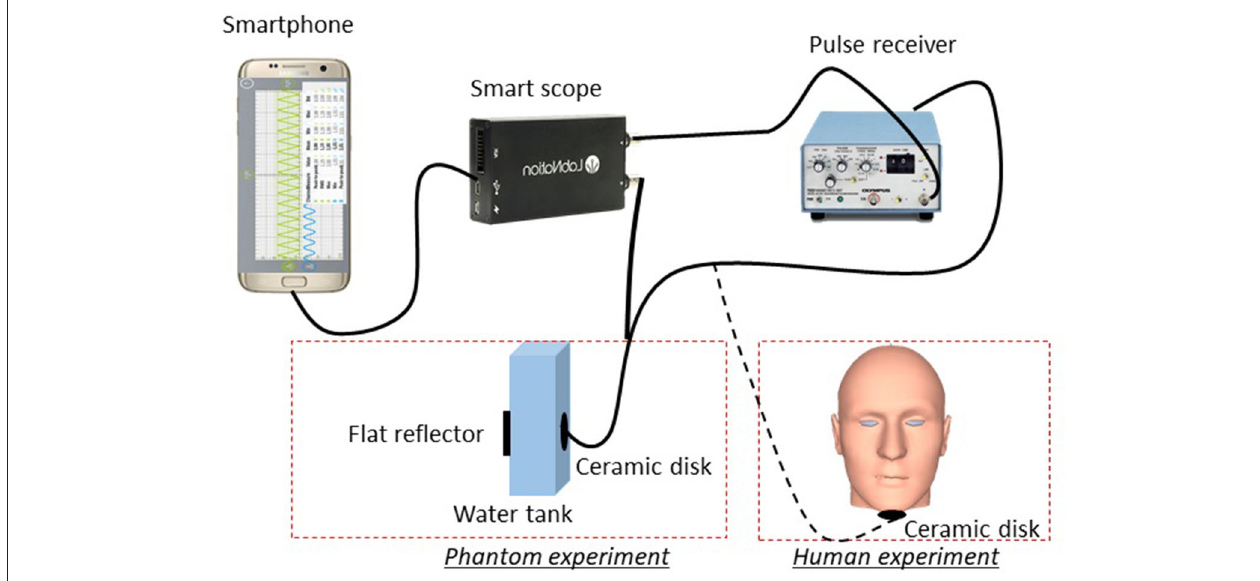
FIGURE 1 | A schematic drawing of the experimental